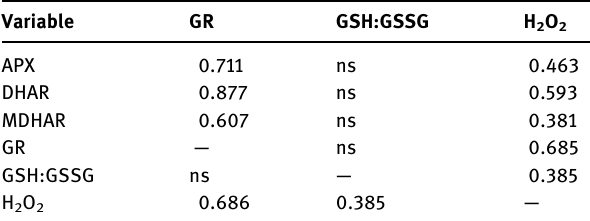
ascorbate – glutathione cycle, GR, reduced - to - oxidized glutathione ratio ( GSH:GSSG ) , and hydrogen peroxide ( H 2 O 2 ) determined in all studied durum wheat plants grown under Cd pollution Variable